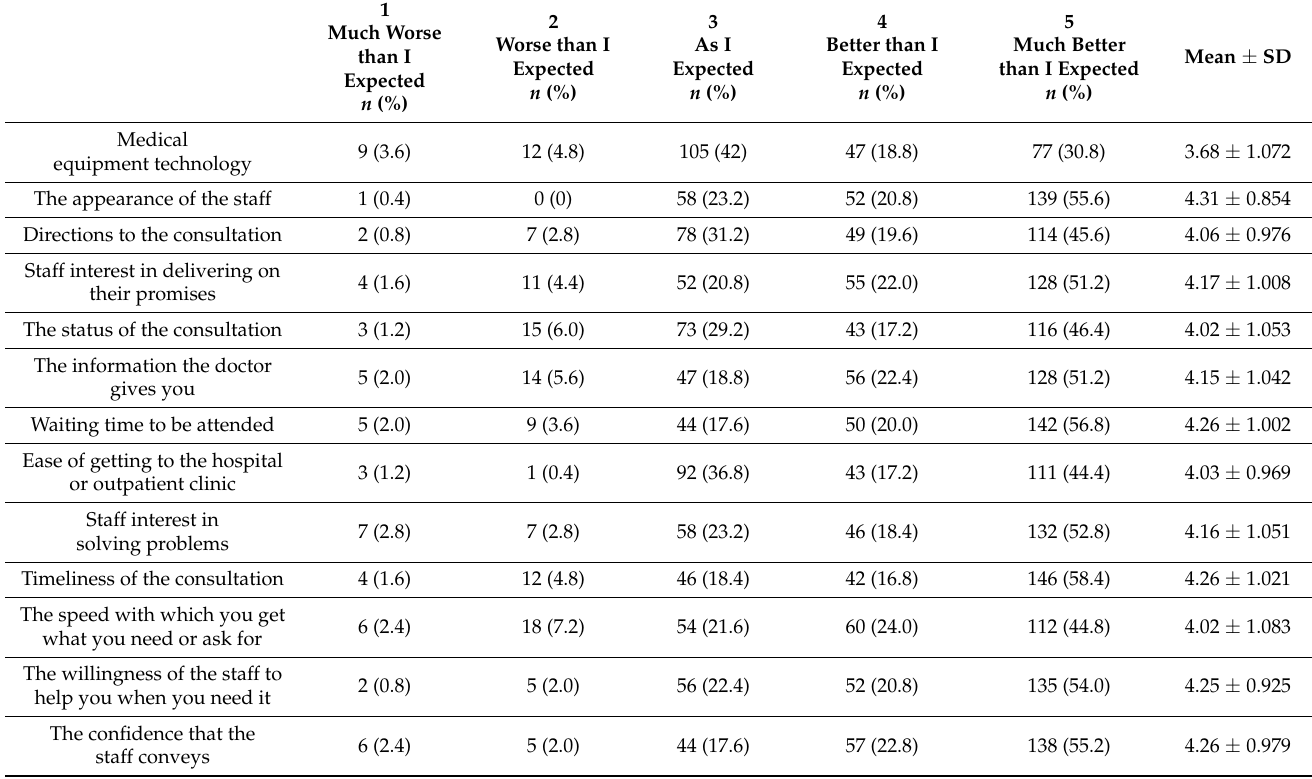
Table 1. Perceived quality of health care in the 19 items of the first block of the